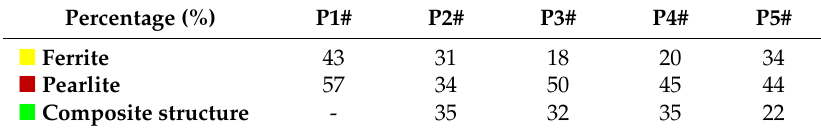
Table 5. Percentages of microstructural constituents for different spray water cooling conditions.